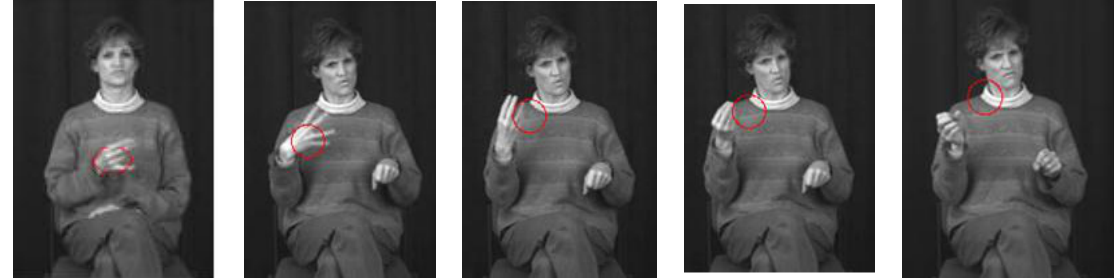
Figure 5. Hand tracking for the usual image by applying just mean shift algorithm.